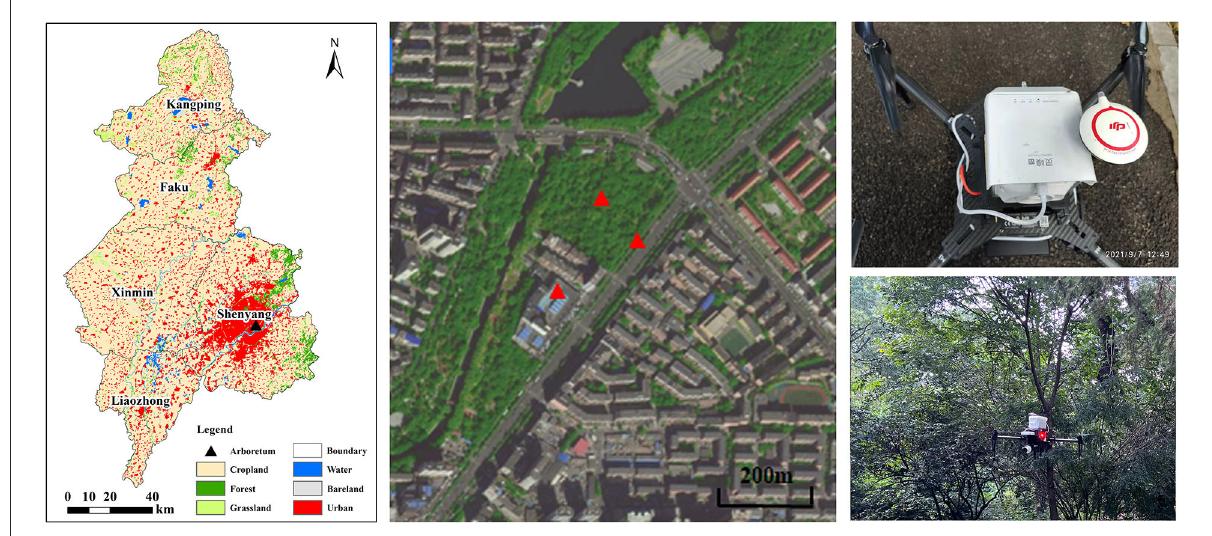
FIGURE1 Location of the Arboretum in Shenyang and unmanned aerial vehicles’ (UAVs’) observation sites in the street canyon, forest, and community areas.